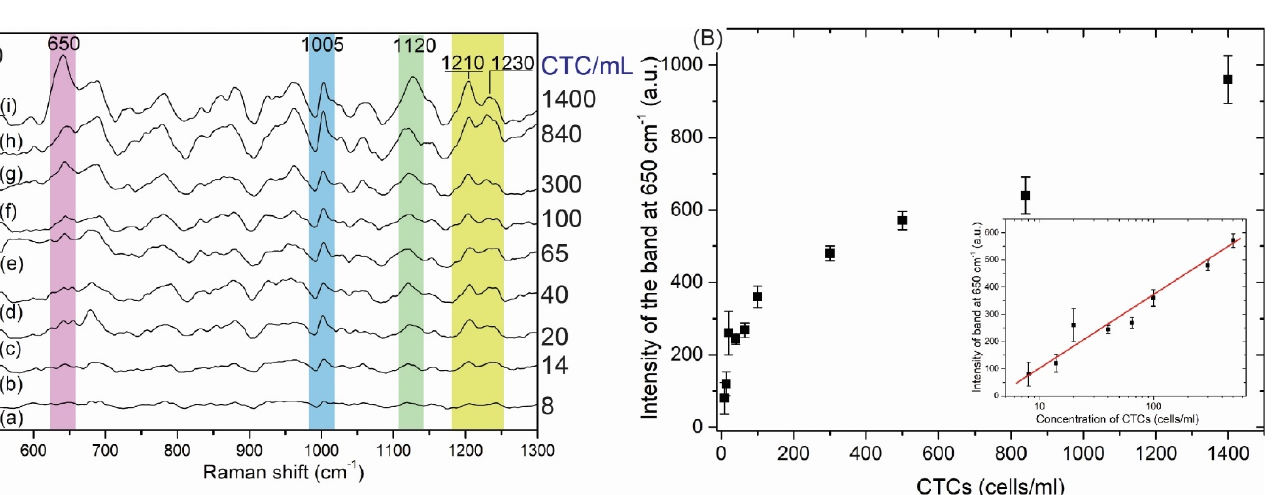
Figure 9. ( A ) SERS signals of selected concentrations of MDA − MB − 231 ranging from 8 to 1400 cells/mL. ( B ) The relationship between the intensity of the marker band at 650 cm − 1 versus the concentration of MDA − MB − 231 in the entire analyzed range of CTC concentrations with an insert showing the linearity of SERS responses between 8 and 500 cells/mL.